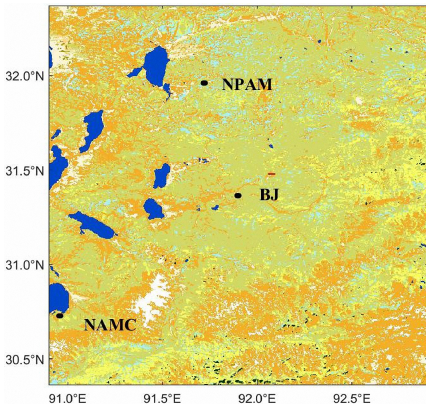
Figure 1. Location of sites and the land cover on the northern Ti- betan Plateau. The black solid circle “ • ” indicates the location of the